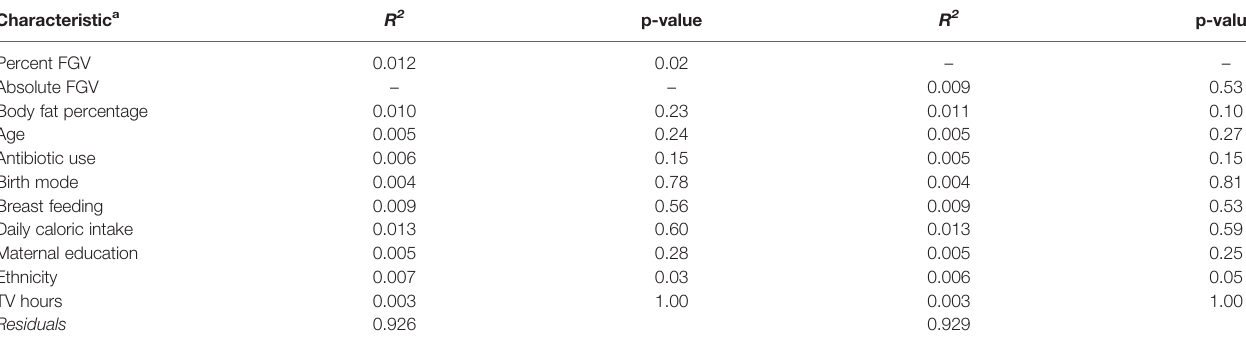
TABLE 2 | Multivariable PERMANOVA analyses to identify variation (R 2 ) in microbial beta diversity (Bray-Curtis dissimilarity) explained by study characteristics. Characteristic a